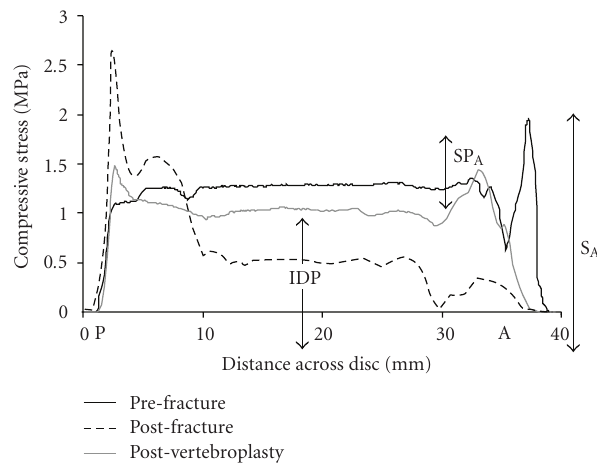
Figure 2: “Stress profiles” show the distribution of compressive stress within the intervertebral disc of a cadaver motion segment (Male 74, L1-2, A: anterior, P: posterior). In the nucleus of the disc, there is a hydrostatic pressure, the intradiscal pressure (IDP). Before fracture, stress is distributed evenly across the disc except for a small stress peak in the anterior annulus (SP A ). After fracture, IDP falls markedly and a large stress peak appears in the posterior annulus. Vertebroplasty restores IDP towards pre-fracture levels and also reduces the height of the stress peak in the posterior annulus. (Reproduced with permission from Luo et al.